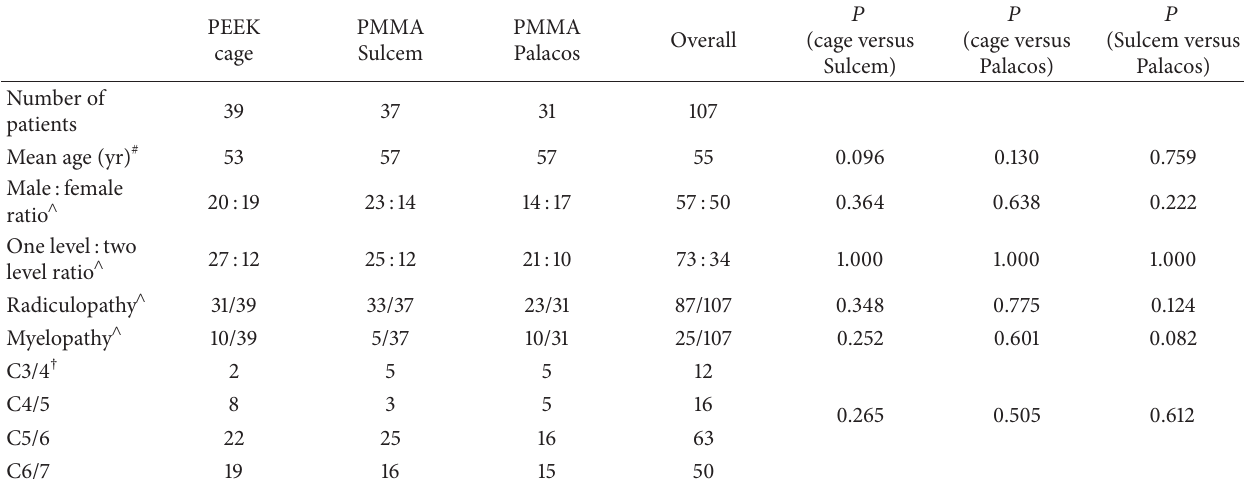
Table 1: Selected demographic and clinical